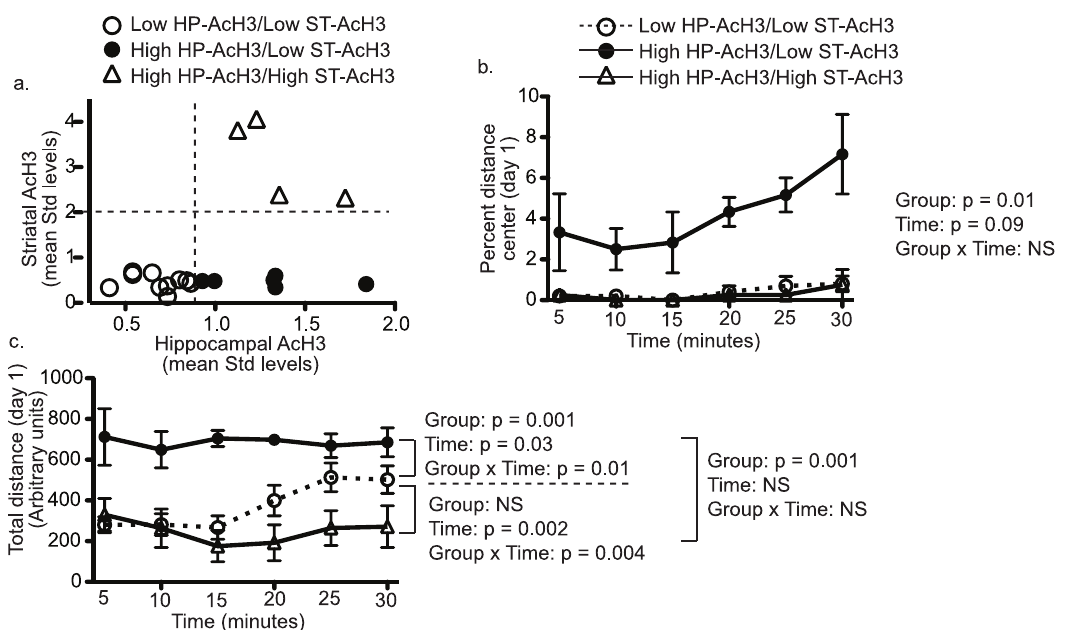
Figure 4. Possible interaction between AcH3 in the hippocampus and striatum. A group of four mice had high levels of AcH3 in the striatum and hippocampus (panel a). In contrast with mice that had high AcH3 only in the hippocampus, these mice were very hypoactive, and were even less active than low hippocampal AcH3 mice. Panel (b) shows a detailed time course for percent distance in the center on day 1 and demonstrates that in this measure, mice with high AcH3 in both regions were indistinguishable from low AcH3 mice (repeated measures ANOVA - main effect of group p=0.01). Panel (c) shows a time course of total distance on day 1 and demonstrates that this group of mice was significantly less active than mice with high AcH3 only in the hippocampus (repeated measures ANOVA - main group effect p=0.001) and mice with low levels of AcH3 in the hippocampus (repeated measures ANOVA - time x group interaction p=0.004). Similar results were seen on other testing days (not shown).